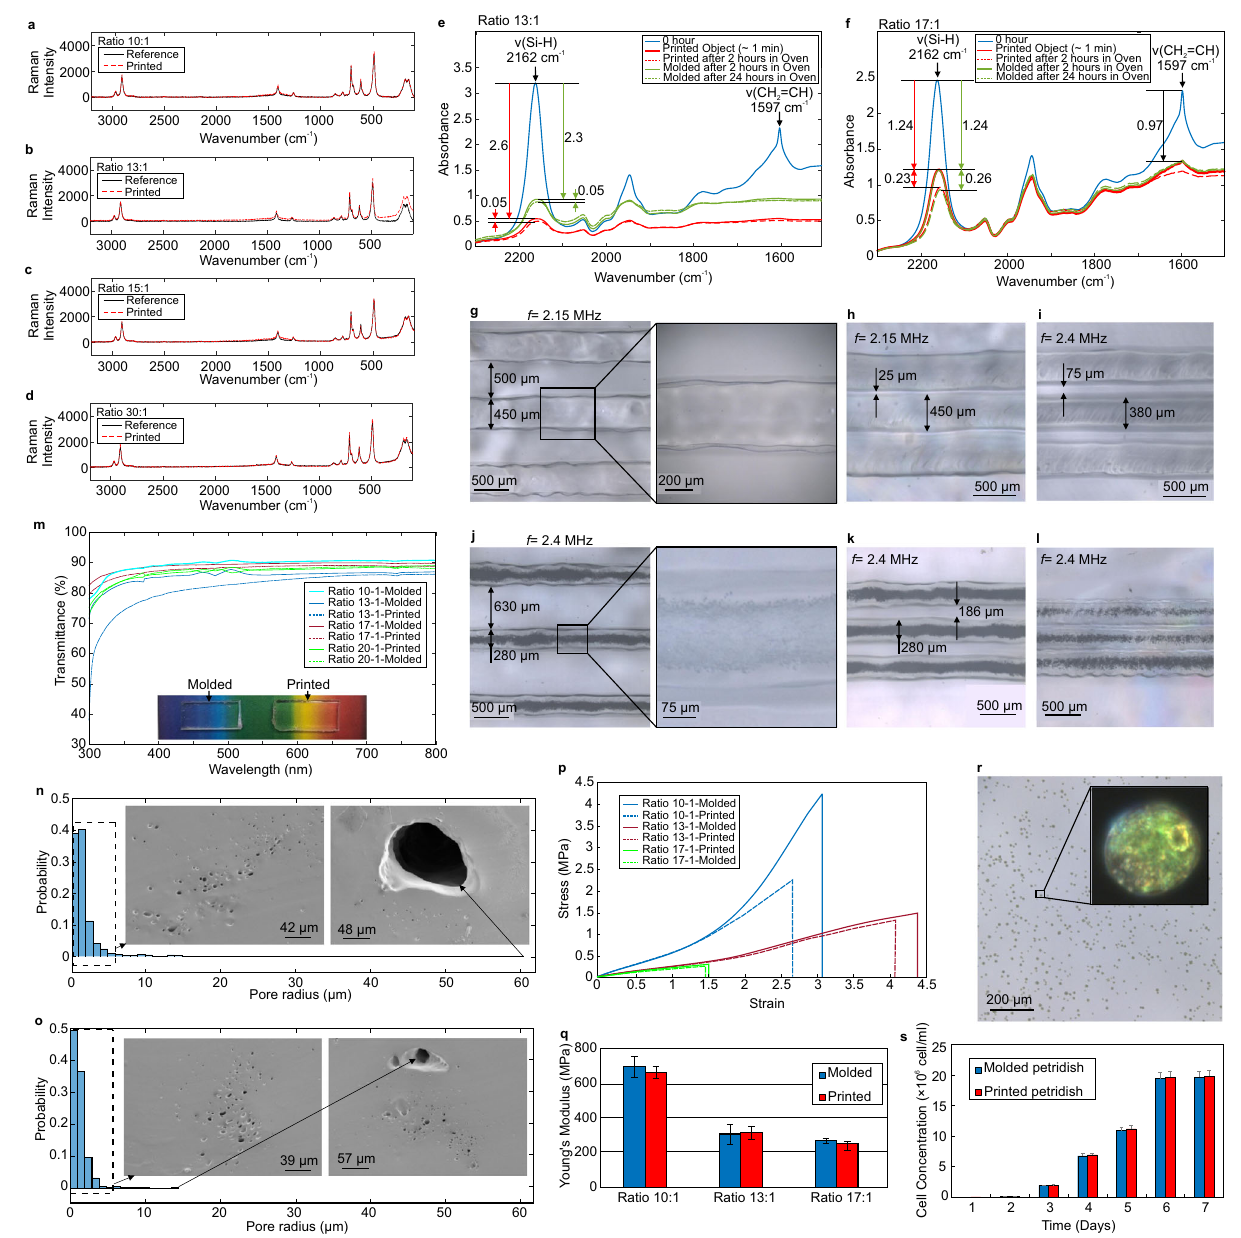
Fig. 4 Process, material and microstructure characterization. a – d Raman spectrums of reference (molded) and printed PDMS for different mixing ratios. e and f IR bands comparison of Si-H (2162 cm − 1 ) and vinyl (1597cm − 1 ) stretches for maxing ratio 13:1 and 17:1, respectively. g – i XY resolution investigation for mixing ratio 15:1. j – l XY resolution investigation for mixing ratio 10:1. m UV – Vis spectrum comparison among printed and molded specimen for different mixing ratios. n and o Samples of pore size distributions for printed objects in 10:1 ratio with frequencies 2 MHz and 3.1 MHz, respectively. Transducer H-316 (natural frequency: 2.5 MHz) is used for printing. p and q Stress – strain curves and Young ’ s Modulus comparison, respectively, of printed and molded specimen for different mixing ratios. r Microscopic picture of a Chlamydomonas reinhardtii at 7th day of cell culture of a printed petridish. s Cell concentration of Chlamydomonas reinhardtii after every day for 7 days for the printed and molded